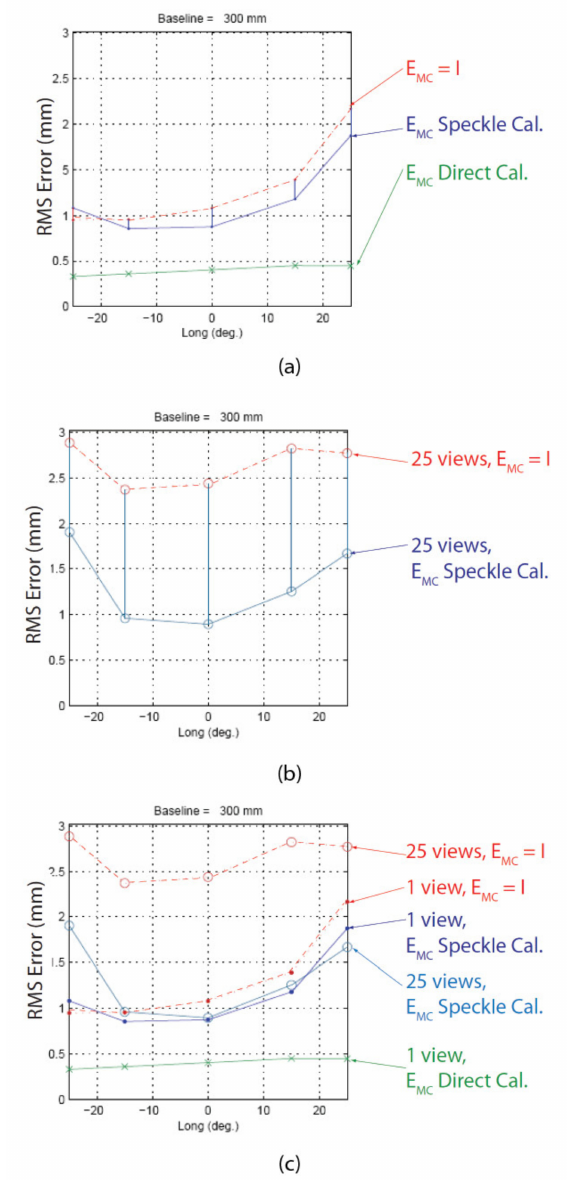
Figure 29. RMS reconstruction error of the discs on the calibration target for 5 different longitudinal orientations of the stereo pair. The red curve corresponds to E MC = I , the blue to E MC calibrated with the speckle-based approach and the green to the ASP calibrated directly as a standard stereo pair ( a ). Reconstruction of the 3D target with 25 different views. The red curve corresponds to E MC = I . The blue curve corresponds to E MC calibrated with the speckle-based approach ( b ). Superimposition of the curves in ( a , b ) on the same plot ( c